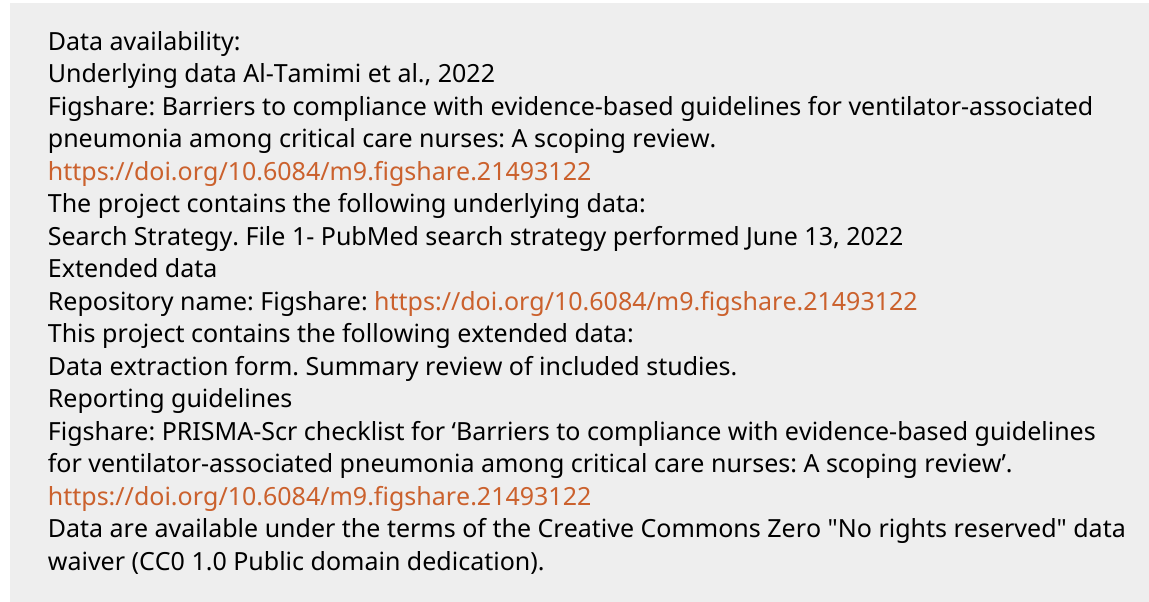
Figshare: PRISMA-Scr checklist for ‘Barriers to compliance with evidence-based guidelines for ventilator-associated pneumonia among critical care nurses: A scoping